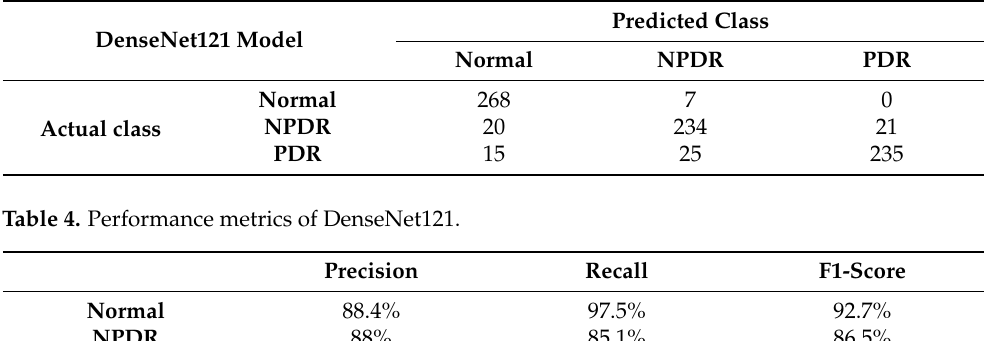
Table 3. The confusion matrix of DenseNet121.